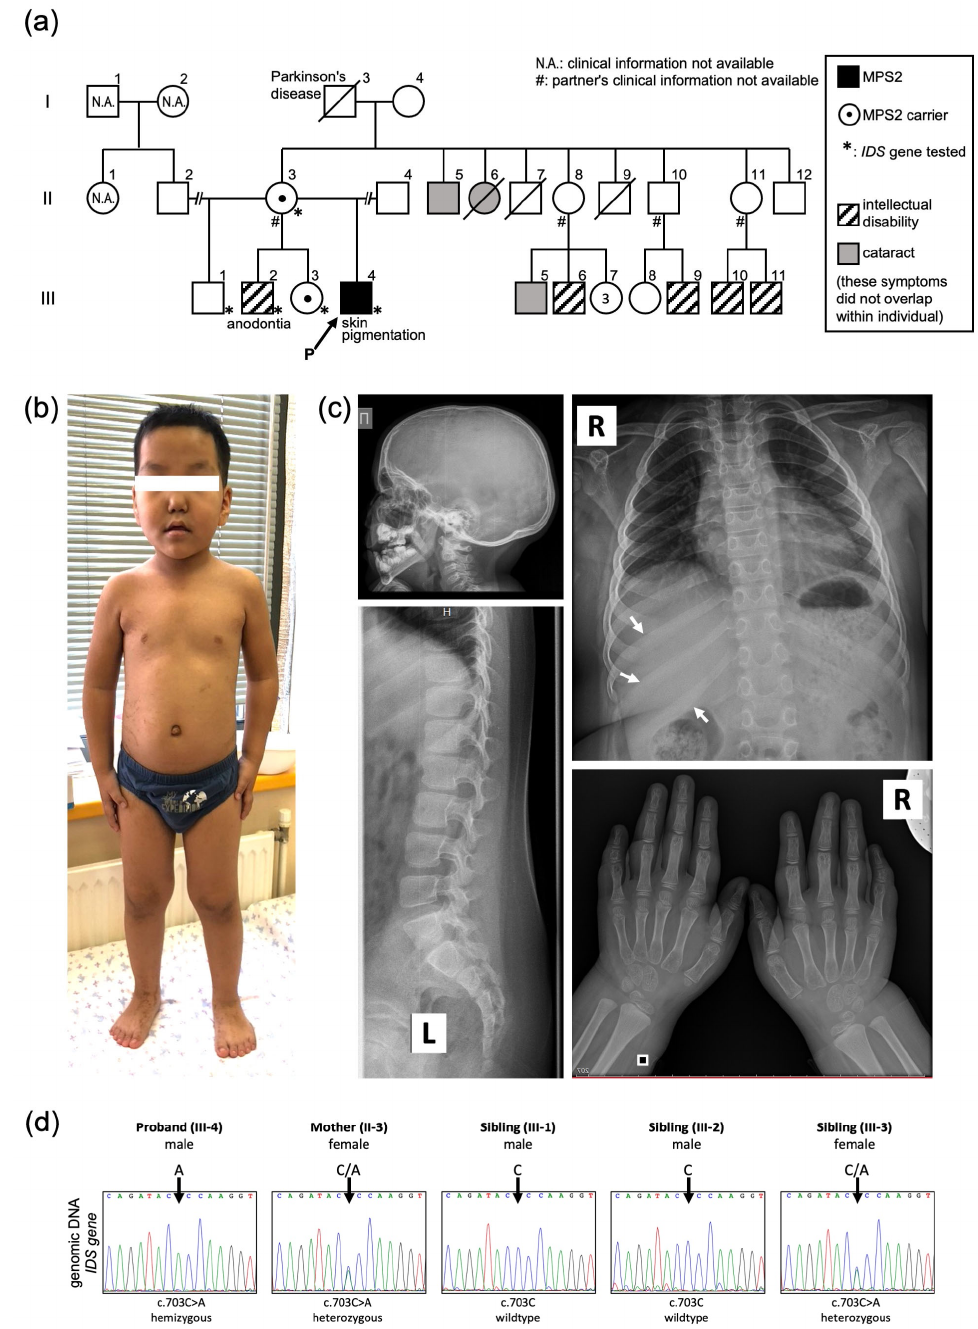
Figure 1. Pedigree, clinical pictures, and genetic diagnosis of MPS II case. ( a ) Family tree of the case. Genetic testing of IDS was performed on II-3, III-1, 2, 3, and 4 (indicated with *). Causes of death were complications from Parkinson’s disease (I-3 at 77 years old), infection (II-6 at 2 months old), and electrical accident (II-7 at 6 years old). ( b ) Whole body image of the proband aged five years and seven months. Slight distinctive facial features, including prominent forehead, broad nasal bridge and hypertelorism, were seen. ( c ) Radiographic images of the proband at the age of seven years. The characteristic finding was absent except for slight widening “oar-shaped“ ribs (indicated by arrows). ( d ) Genetic test of IDS gene with Sanger sequencing. A missense variant c.703C>A was identified in the proband (III-4), proband’s female sibling (III-3), and mother